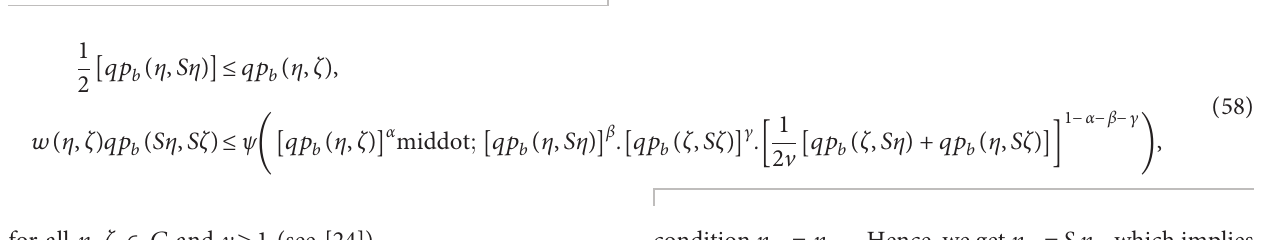
Figure 2: The 3-D plane in yellow represents the quasi-partial b-metric space defined by the function, qp point of S is